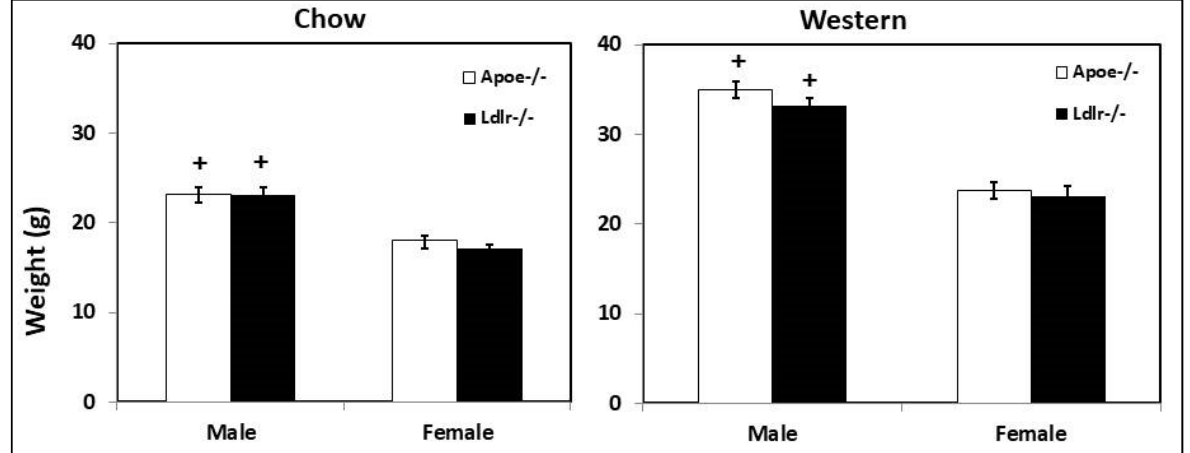
Figure 7. Body weight (g) of male and female C3H- Apoe -/- and C3H- Ldlr -/- mice fed a chow or a Western diet. Chow-fed mice were weighed at 3 months of age, and Western diet-fed mice were weighed after being euthanized. Results are means ± SE of 4 to 26 mice. + p < 0.05 vs. female mice.